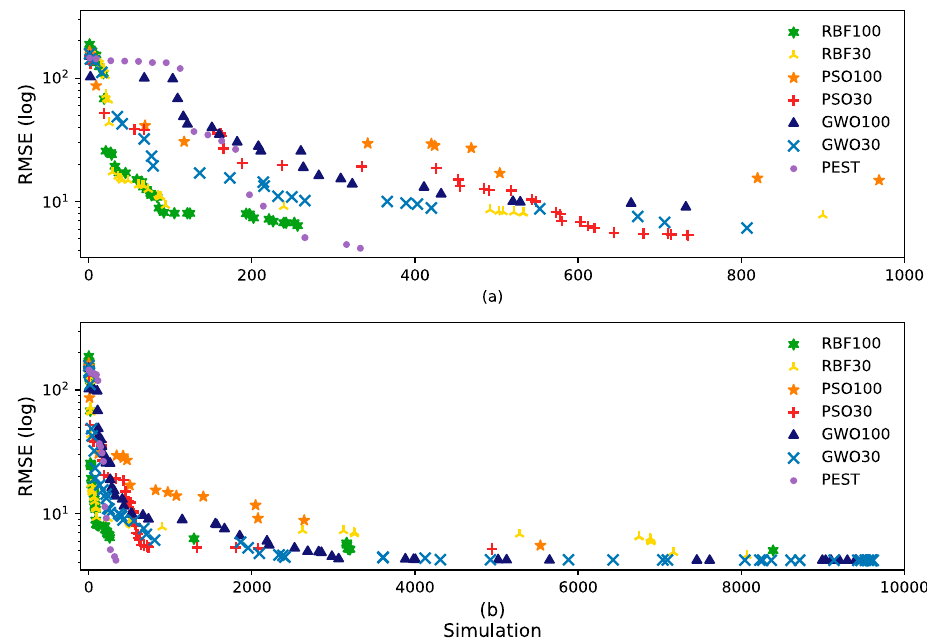
Figure 3. RMSE improvements with simulation of the best run of each method—( a ) 1000 simulations and ( b ) 10,000